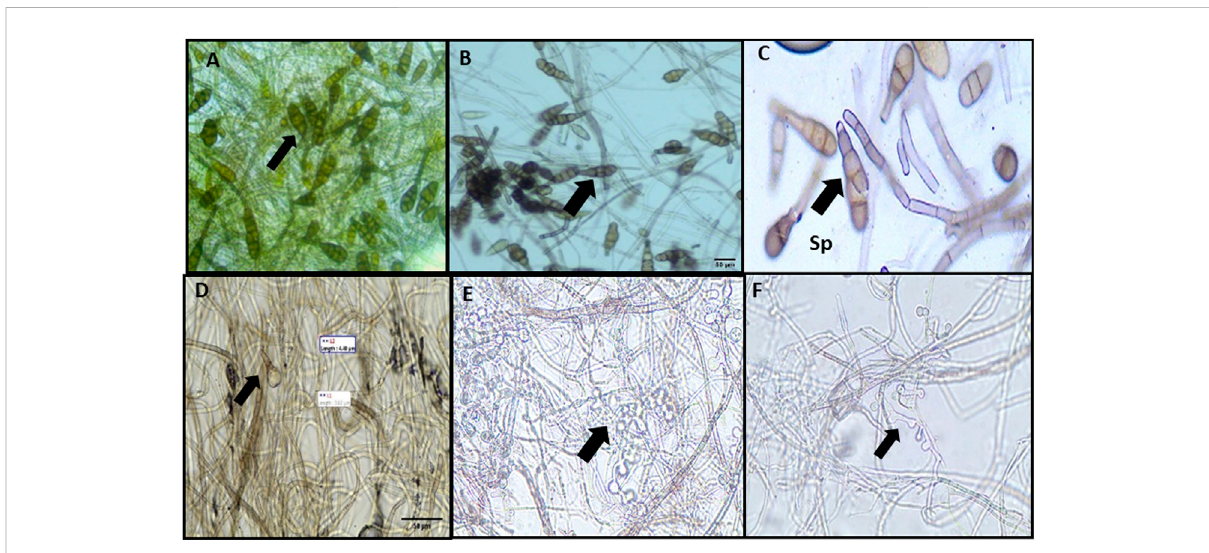
FIGURE 11 Effect of C - CuO NPs on the morphology of A. brassicae: (A) control: septated hyphae and long obpyriform conidia; (B) 25 ppm: long obpyriform conidia; (C) 50 ppm: less horizontal septa were observed in conidia; and (D – F) 100 – 200 ppm: less horizontal septation in conidia and spore decreased.